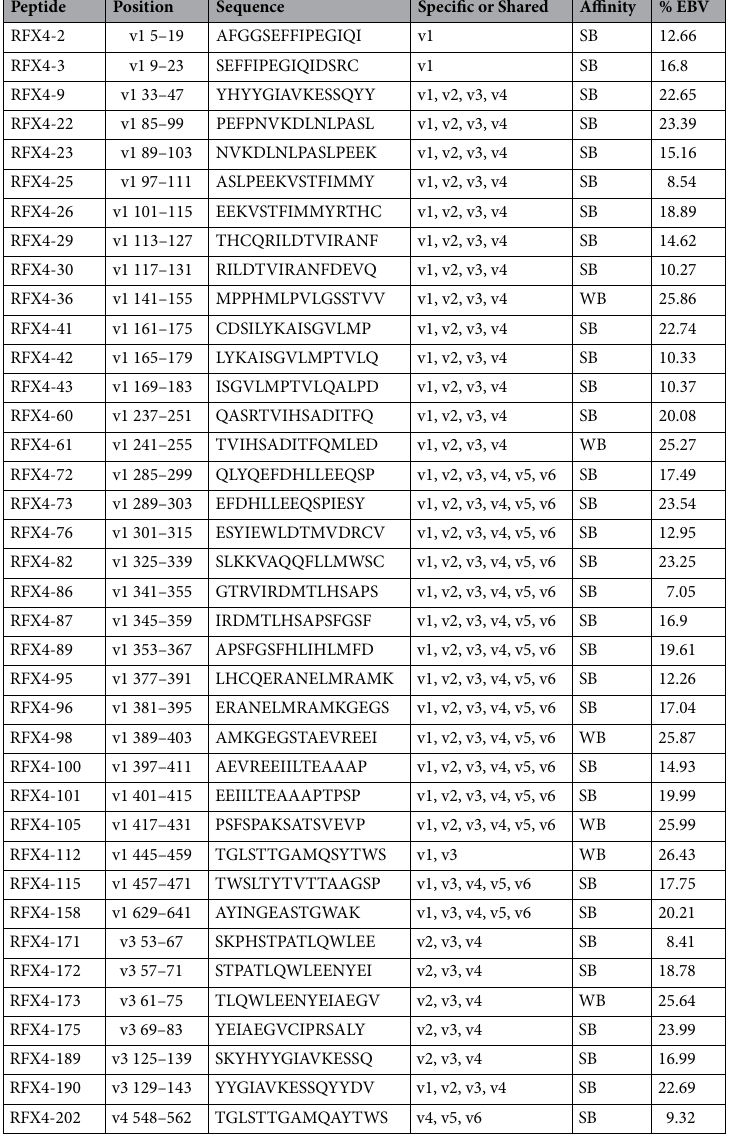
Table 2. RFX4 peptides for tetramer DQ0602. SB strong binder, WB weak